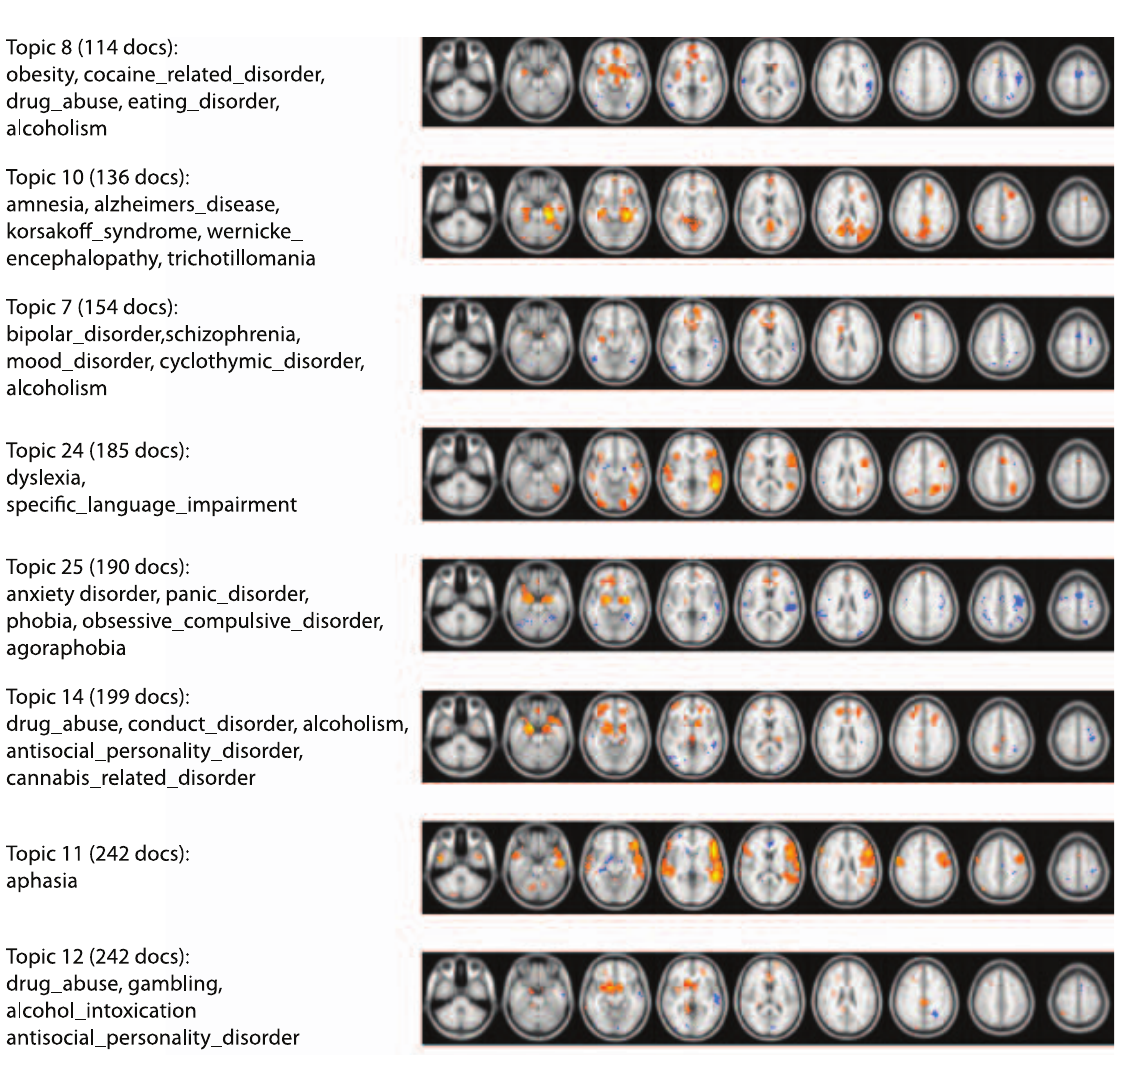
Figure 6. Examples of topic maps based on a topic model limited to disorder-related terms. Topics are ordered in terms of the number of documents loading on the topic; color maps reflect the correlation coefficient between topic loading and activation across documents. The images are presented in radiological convention (i.e., left-right reversed).